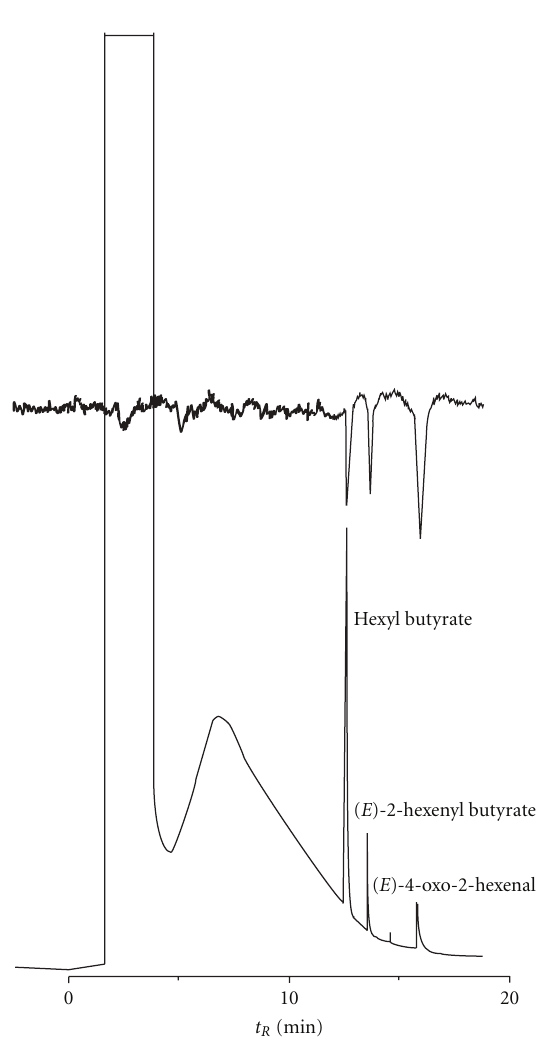
Figure 3: Coupled gas chromatography-electroantennographic detection (GC-EAD) chromatograms showing the responses from an antenna of a male Stenotus rubrovittatus (top trace) to a crude extract of unmated females.